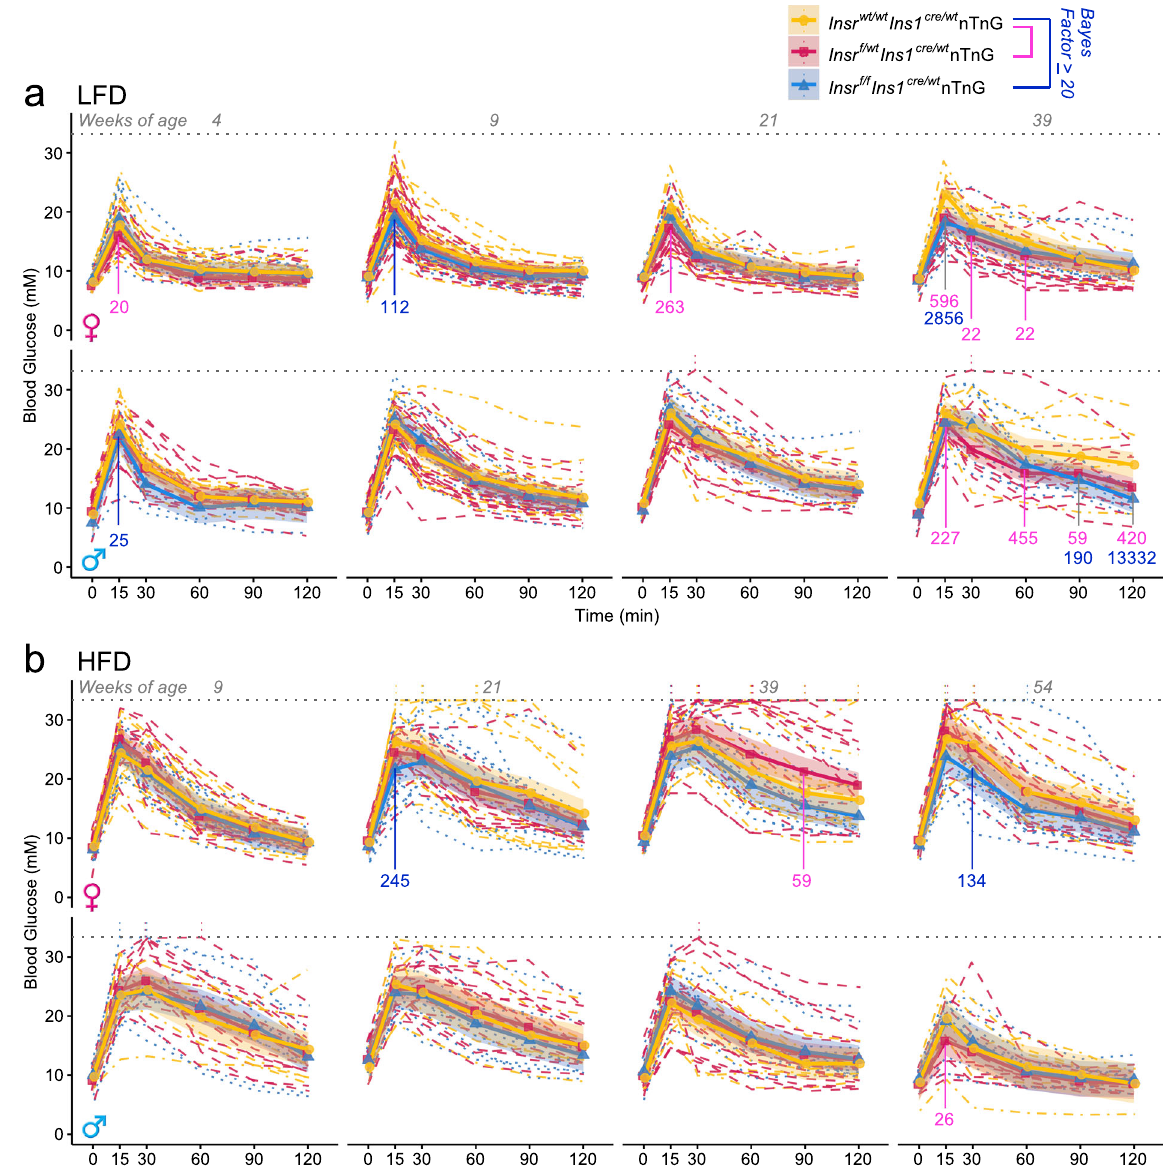
Fig. 8 Bayesian regression modeling of glucose tolerance at multiple ages in β -cell speci fi c Insr knockout mice fed two different diets. Modelled from the same data as Fig. 7. a Tail blood glucose levels (mM) from glucose tolerance tests of control (yellow), β Insr HET (red), β Insr KO (blue) LFD-fed female as well as b HFD-fed female and male mice ( n = see Fig. 7). All mice received a glucose bolus of 2 g glucose/kg body mass (i.p) except older HFD-fed males, which received only 1 g glucose/kg body mass (i.p ). Data were analysed using Bayesian multilevel regression modeling. Bayes factors greater to or equal to 20 for individual time points are shown in pink for comparisons between control and β Insr HET , and blue for comparisons between control and β Insr KO . Additional Bayes factors can be found in Supplemental Table S3. Dashed lines indicate individual mice, solid lines and points indicate estimates, and shading indicates 95% credible intervals. Dotted line at 33.3 mM indicates the upper limit of detection of the glucometer and vertical dotted lines rising above this line indicate where measurements were above the limit of detection for an individual mouse. Source data are provided as Source Data fi